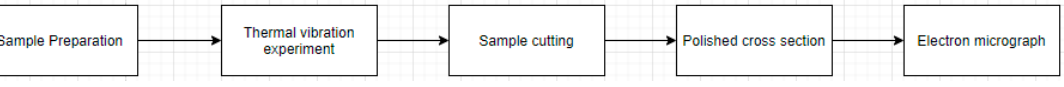
Figure 1. Experiment process.